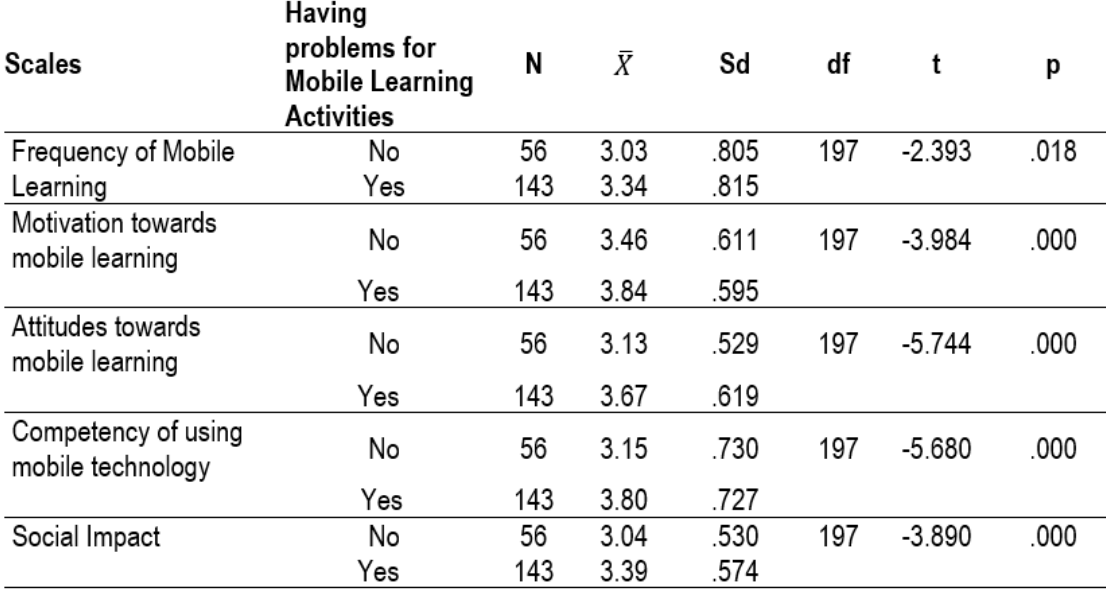
Independent samples t-test analysis on having adequate technology for mobile learning activities